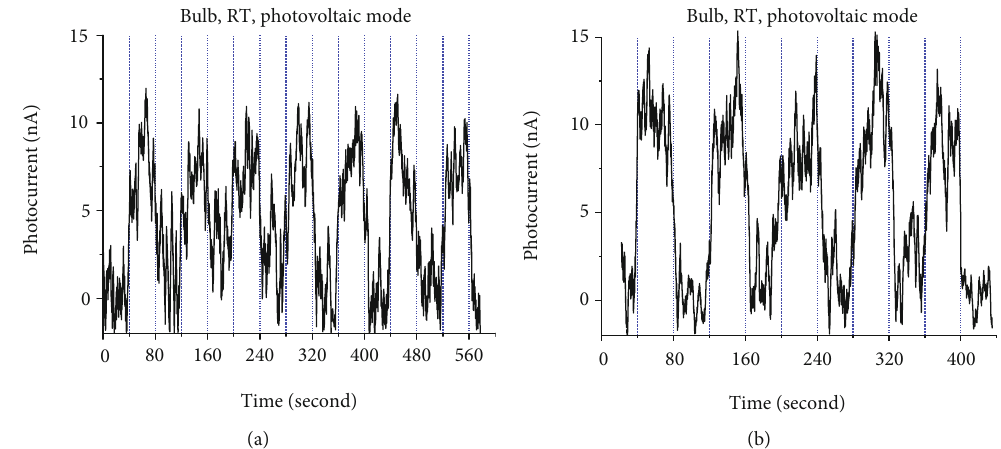
Figure 3: Responses of (a) 1 st and (b) 2 nd n -ZnO NW/ p -MoS respectively, during cyclic tests with 80 s period at room temperature (RT) and photovoltaic mode.